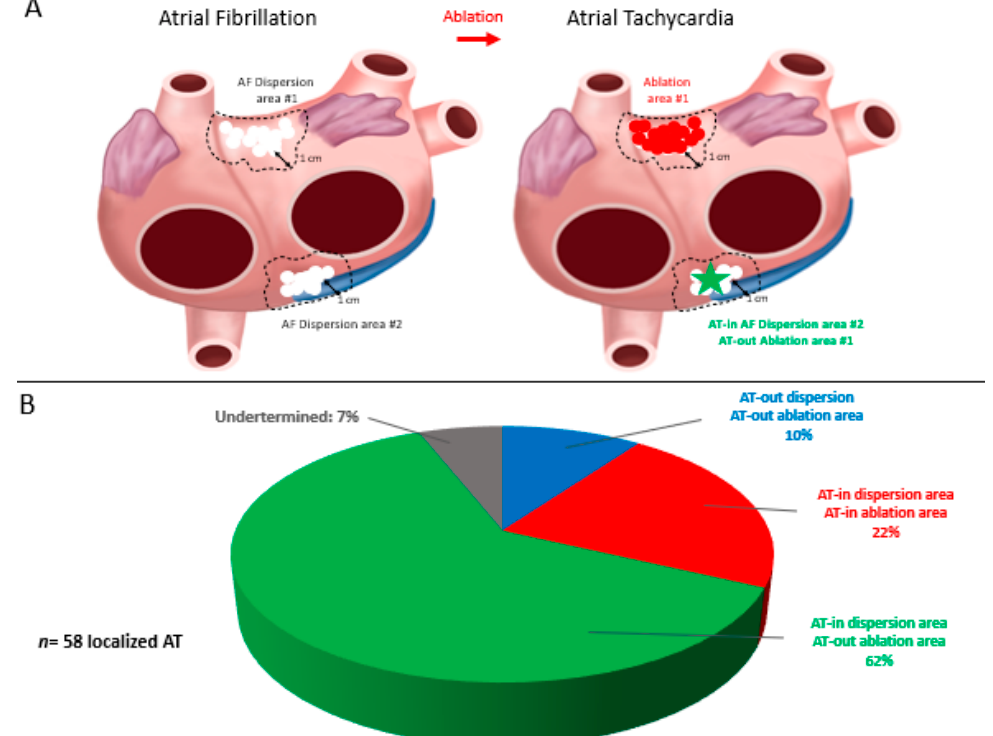
Figure 3. ( A ) Schematic of localized AT located in an AF dispersion unablated area. After bi-atrial dispersion mapping in AF (left picture), two regions of dispersion are highlighted. After ablation of the upper anterior dispersed site, AF turns into AT, found to be localized at the ostium of the coronary sinus ( B ). Spatial relationship between localized AT and dispersion and/or ablation areas. 62% of localized Ats were found to be in sites with dispersion pattern during AF, far from closest ablated region.